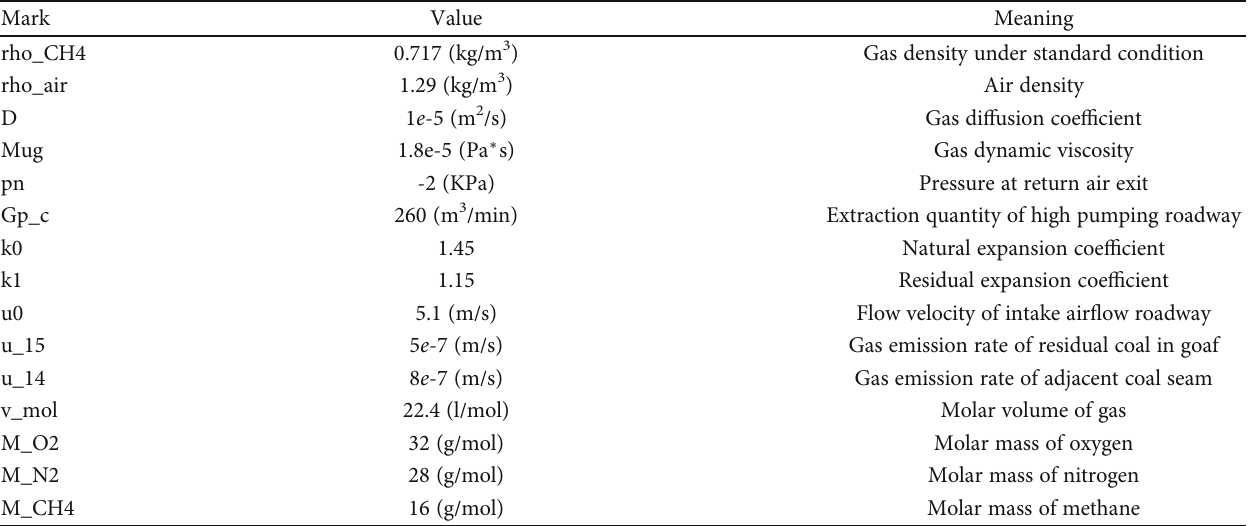
Figure 4: Schematic diagram of mesh division. Table 1: Numerical simulation